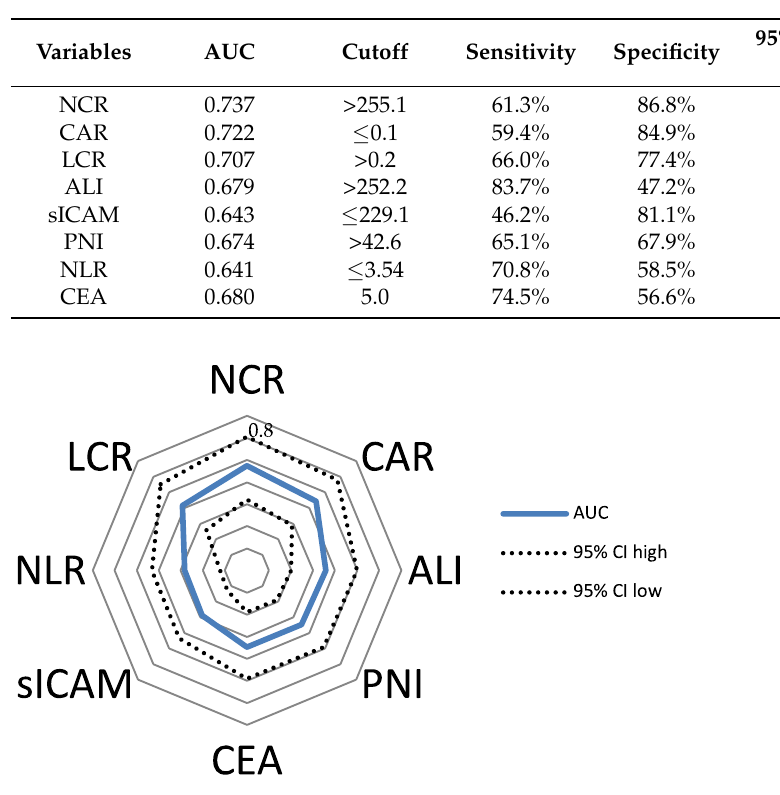
Figure 1. Side-to-side comparison of AUCs for different parameters predicting the OS of the discov- ery cohort.